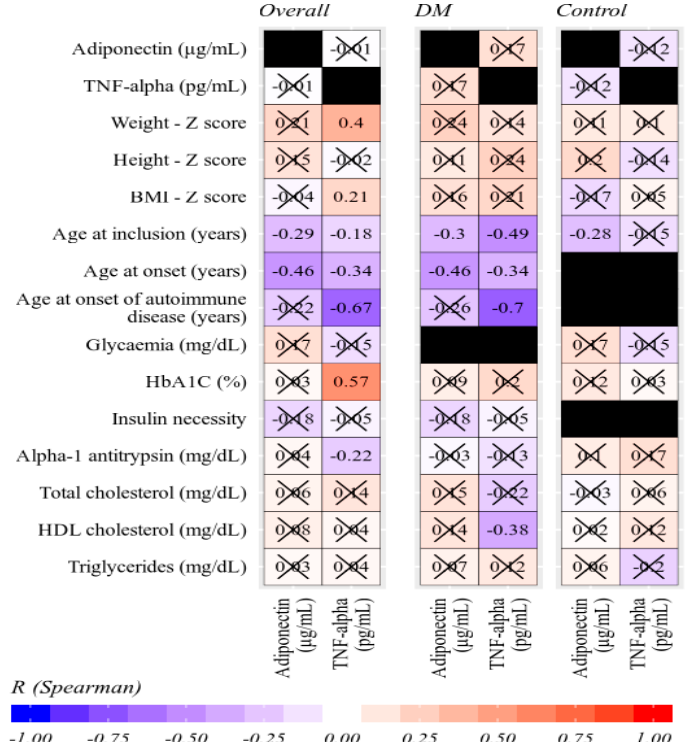
Figure 2. Correlation matrix of adiponectin and TNF- α values with several other parameters (Spearman’s R coefficients, statistically insignificant values crossed out).